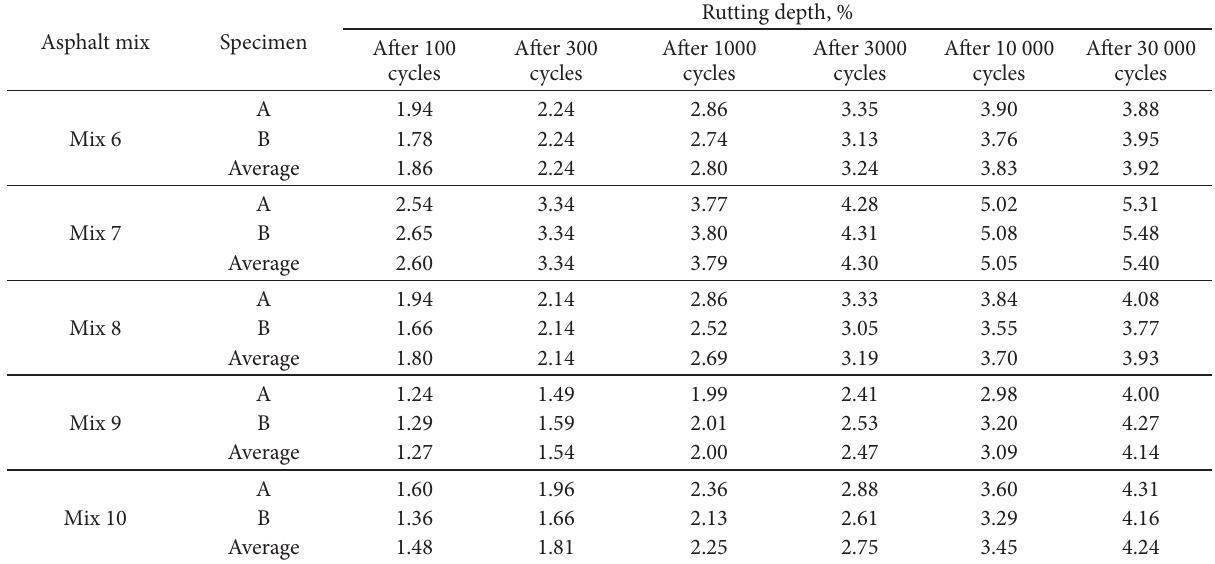
Table 7. FLRT rutting results for different HMA mixes Asphalt